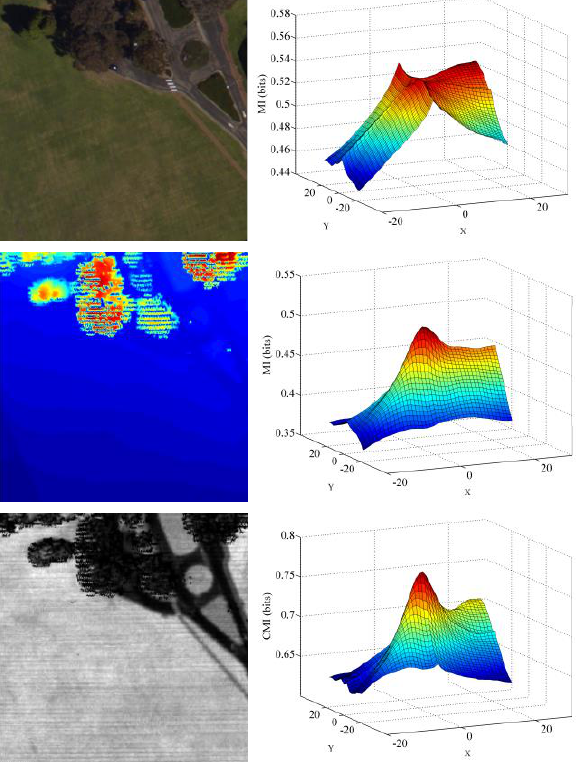
Figure 8. Aerial image, LiDAR DSM and intensity image (left column). Also, MI convergence surface of LiDAR DSM and intensity image and CMI convergence surface of image and LiDAR data for translation in x and y directions (right column).